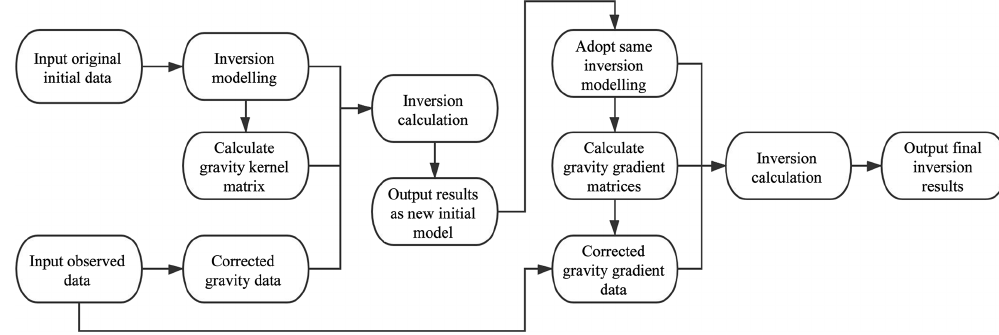
Figure 4. The flowchart for the whole PCG inversion algorithm